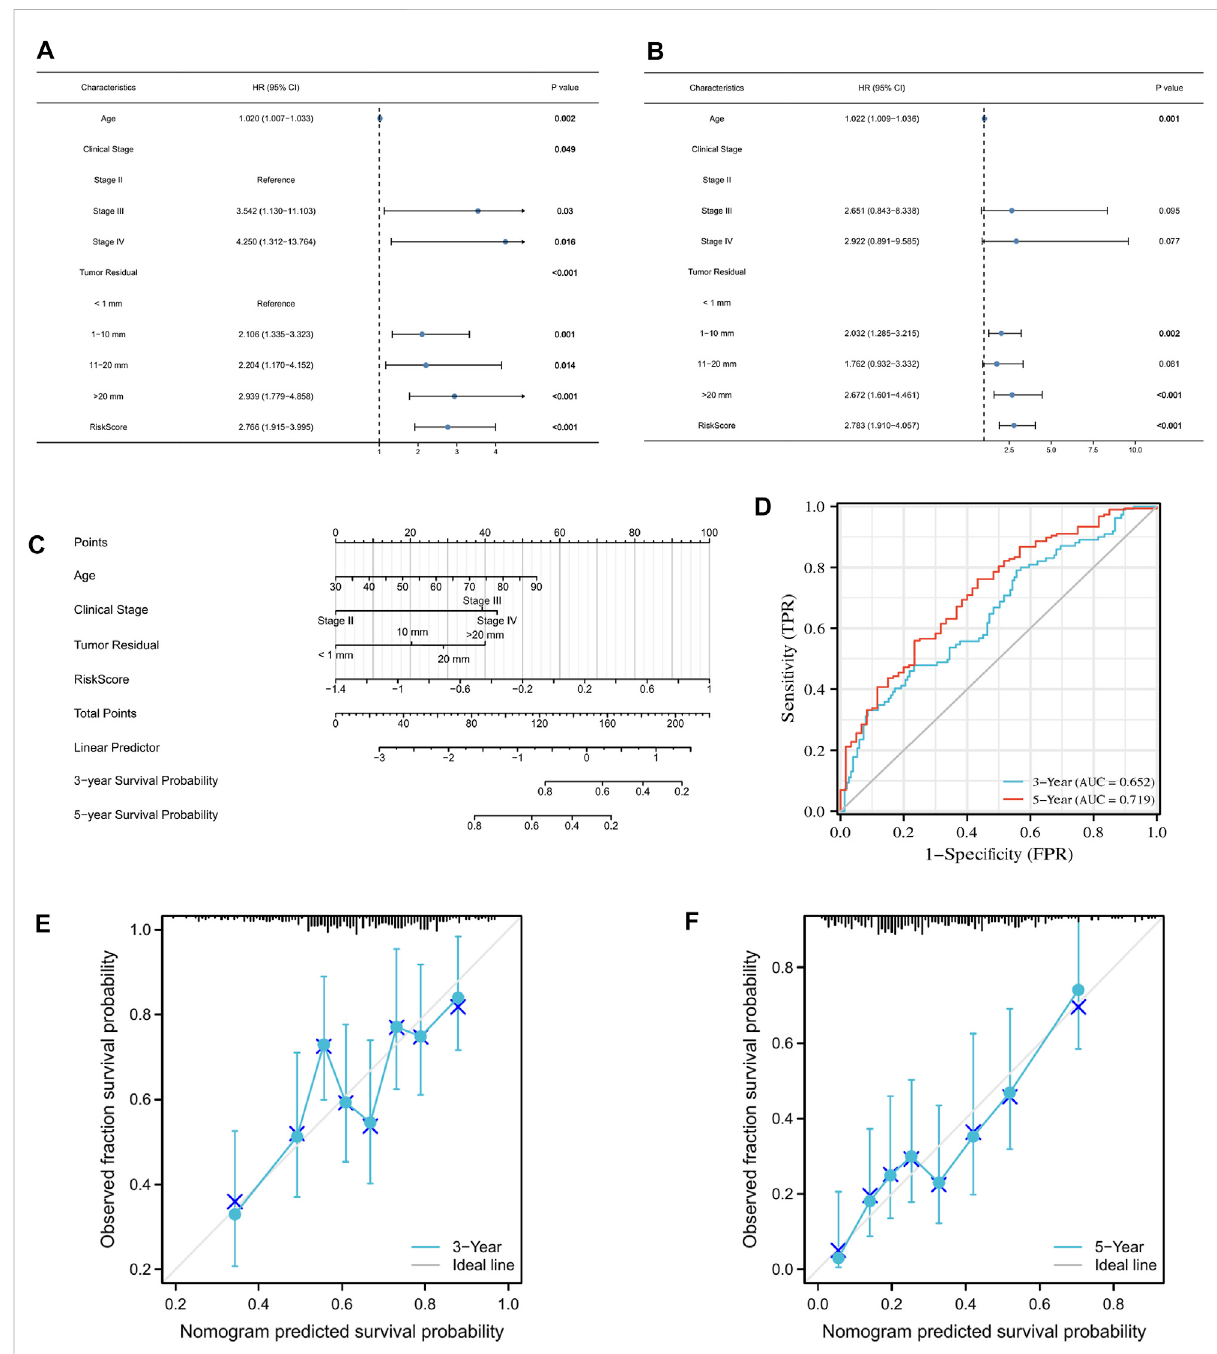
FIGURE 8 Construction of a nomogram that accurately predicts OC prognosis. (A,B) Univariate and multivariate Cox regression model incorporating clinicopathological factors and risk score. (C) Nomogram model based on risk model and clinical features. (D) Predictive ef fi cacy of the